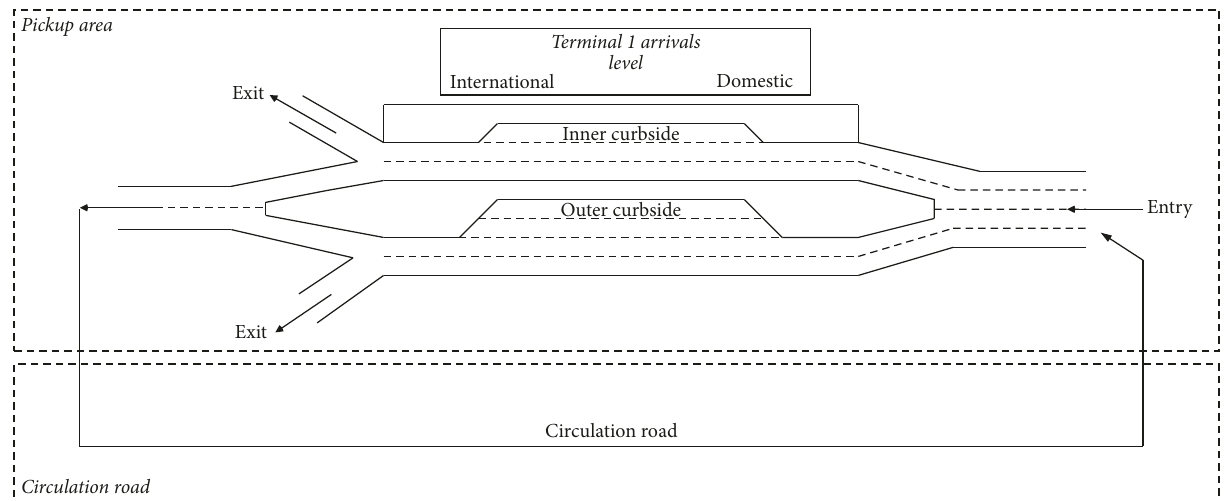
Figure 1: Curbside layout for the